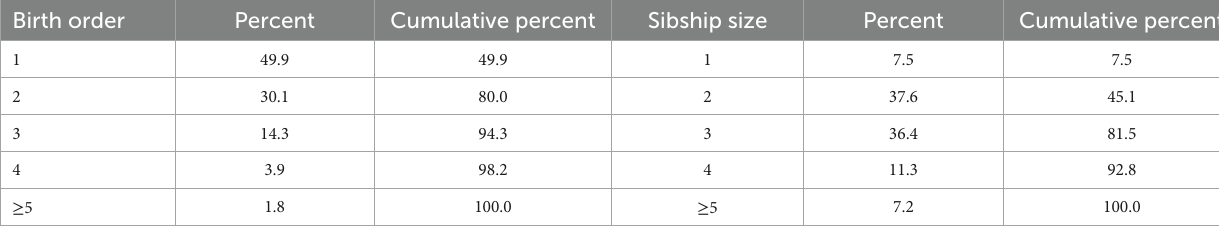
TABLE 1 Birth order and sibship size percentages. Birth order Percent Cumulative